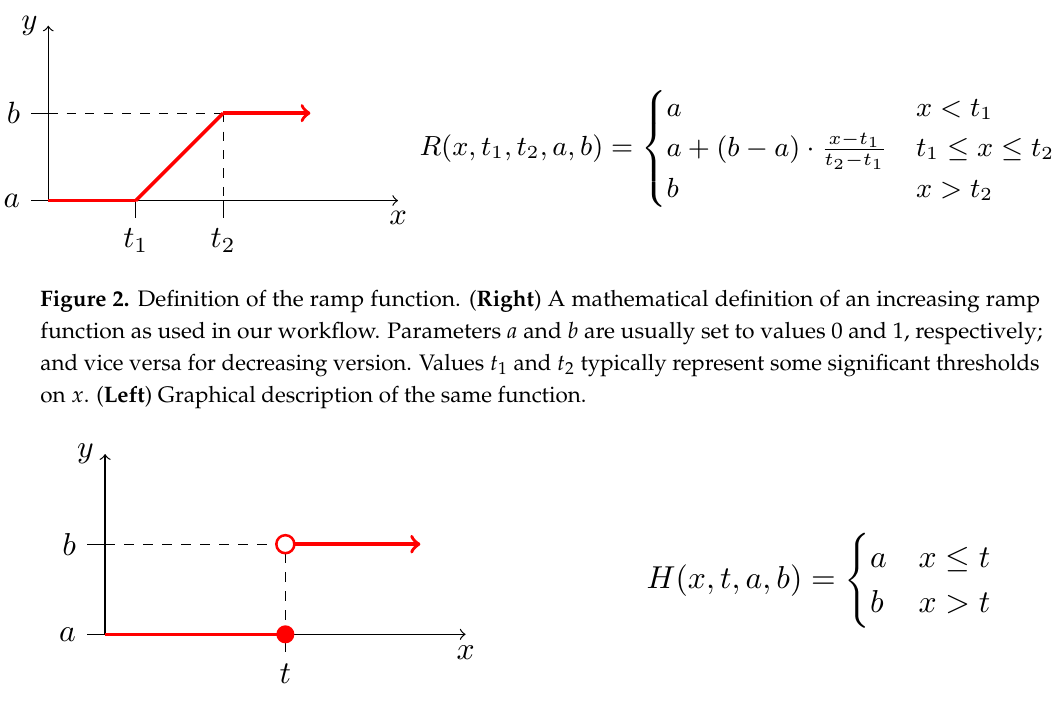
Figure 3. Definition of the Heaviside step function. ( Right ) A mathematical definition of an increasing Heaviside step function as used in our workflow. Parameters a and b are usually set to values 0 and 1, respectively; and vice versa for decreasing version. Value t typically represents an important threshold in the domain of x . ( Left ) Graphical description of the function—specifically, the increasing